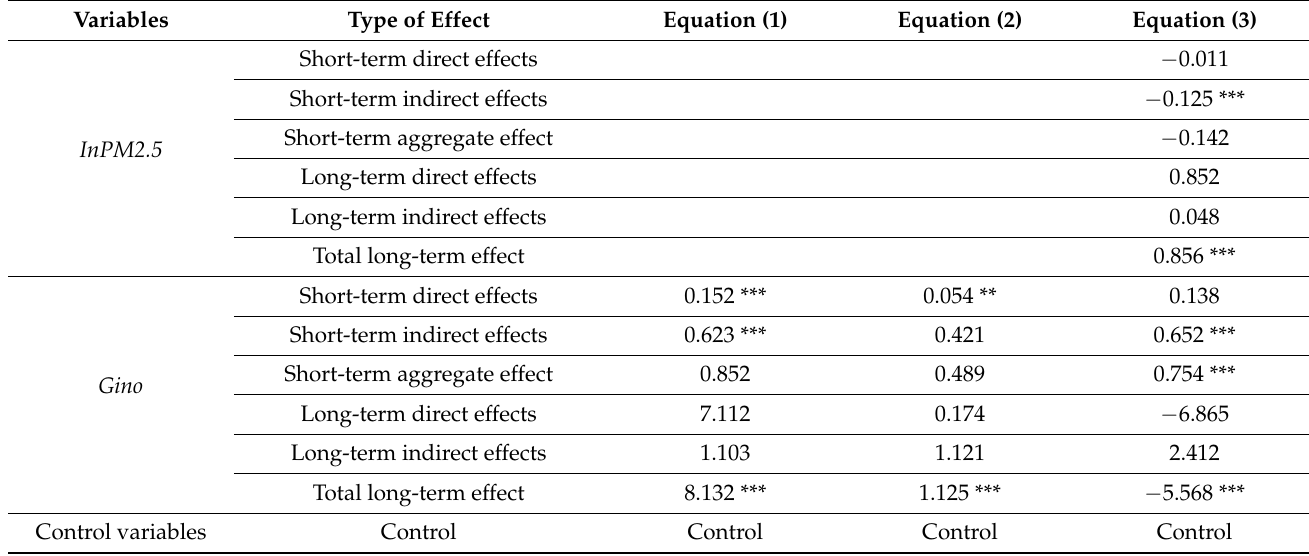
Table 9. Mediating effect test based on